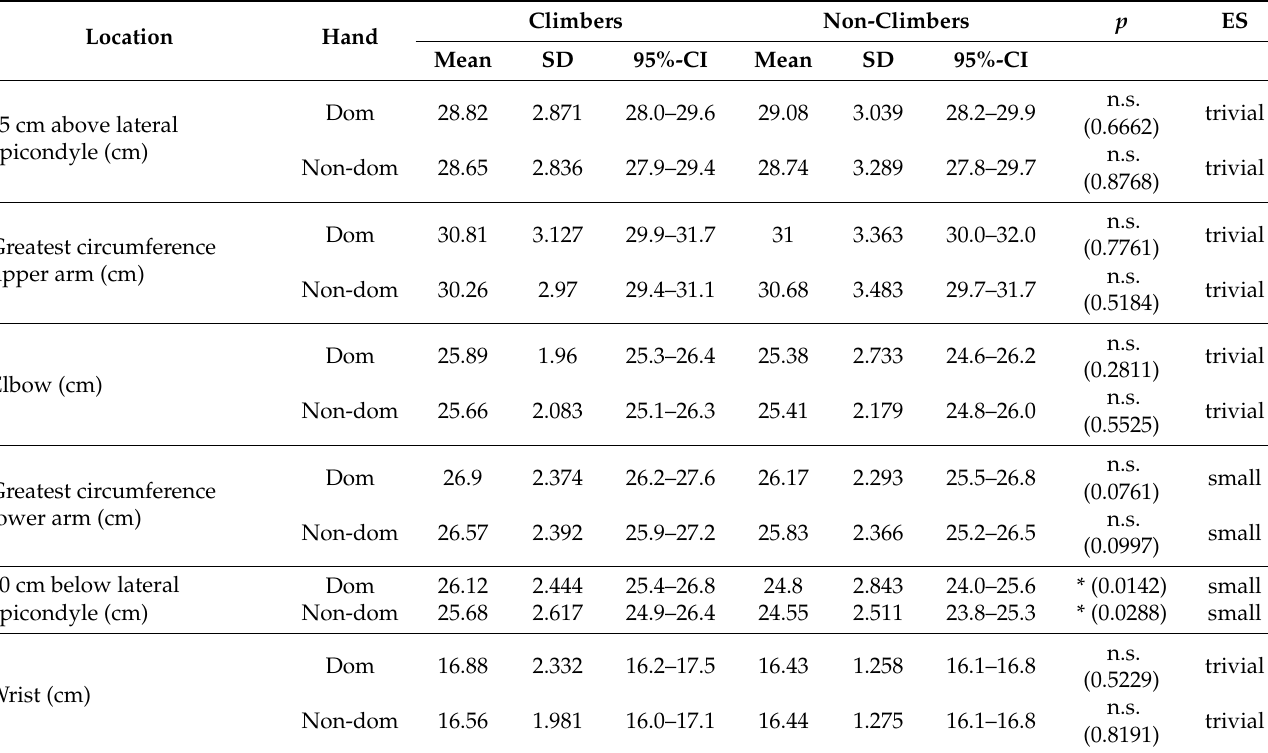
Table 1. Analysis of circumference on defined locations between both groups. Means of climbers and non-climbers are compared to each other (unpaired t-test) and effect size (ES) is